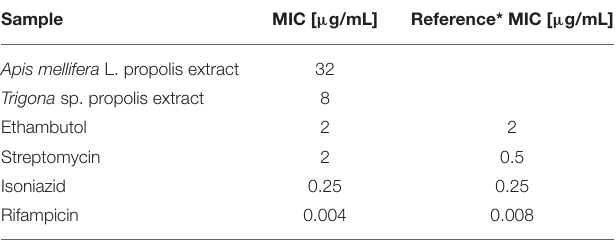
TABLE 2 | MIC values of propolis extract and antibiotics against M. tuberculosis H37Ra.